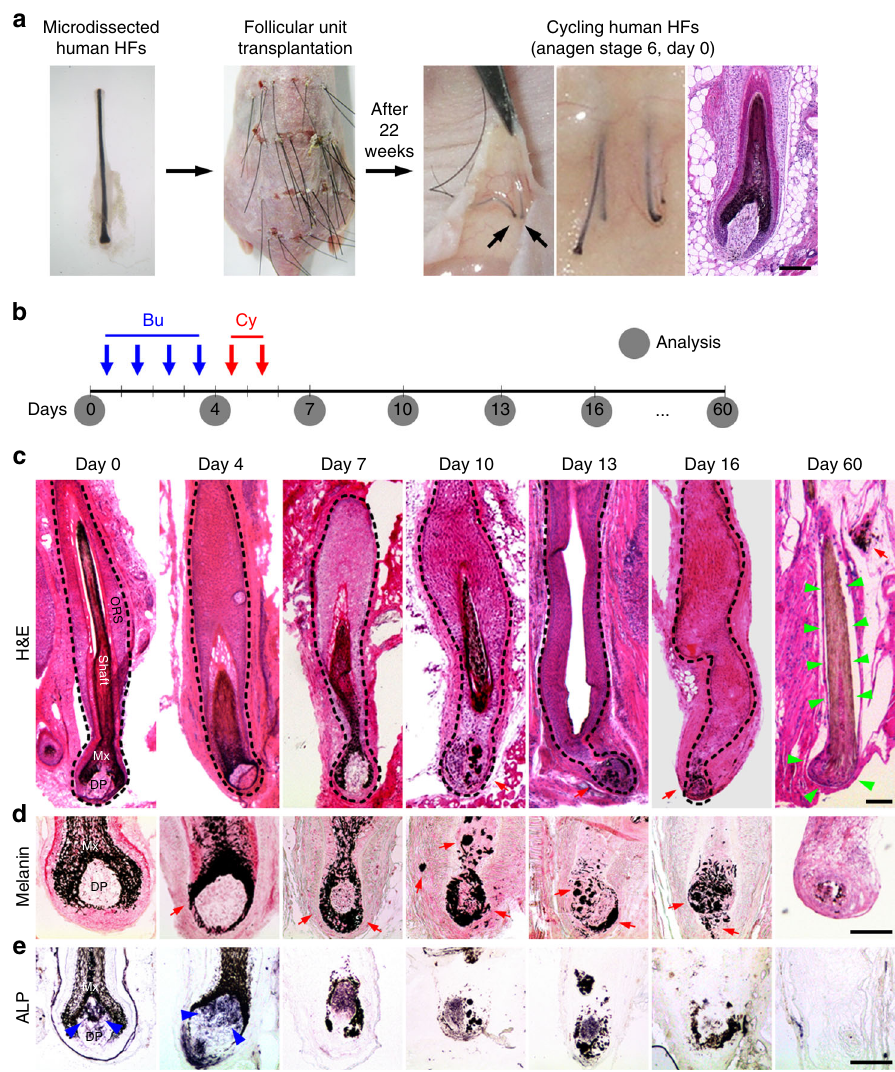
Fig. 1 Permanent loss of HF regeneration after Bu/Cy treatment. a Experimental model of cycling human HFs for the investigation of permanent loss of regeneration after alkylating chemotherapy. Microdissected human HFs were transplanted into severe combined immunode fi ciency hairless outbred mice ( n = 765 transplanted HFs, 32 mice). After 22 weeks of transplantation, human HFs were regenerated into terminal HFs showing anagen stage 6 morphology. b Schedule for sequential Bu/Cy treatment (Bu 20 mg/kg/day, Cy 100 mg/kg/day) into mice with transplanted human HFs, followed